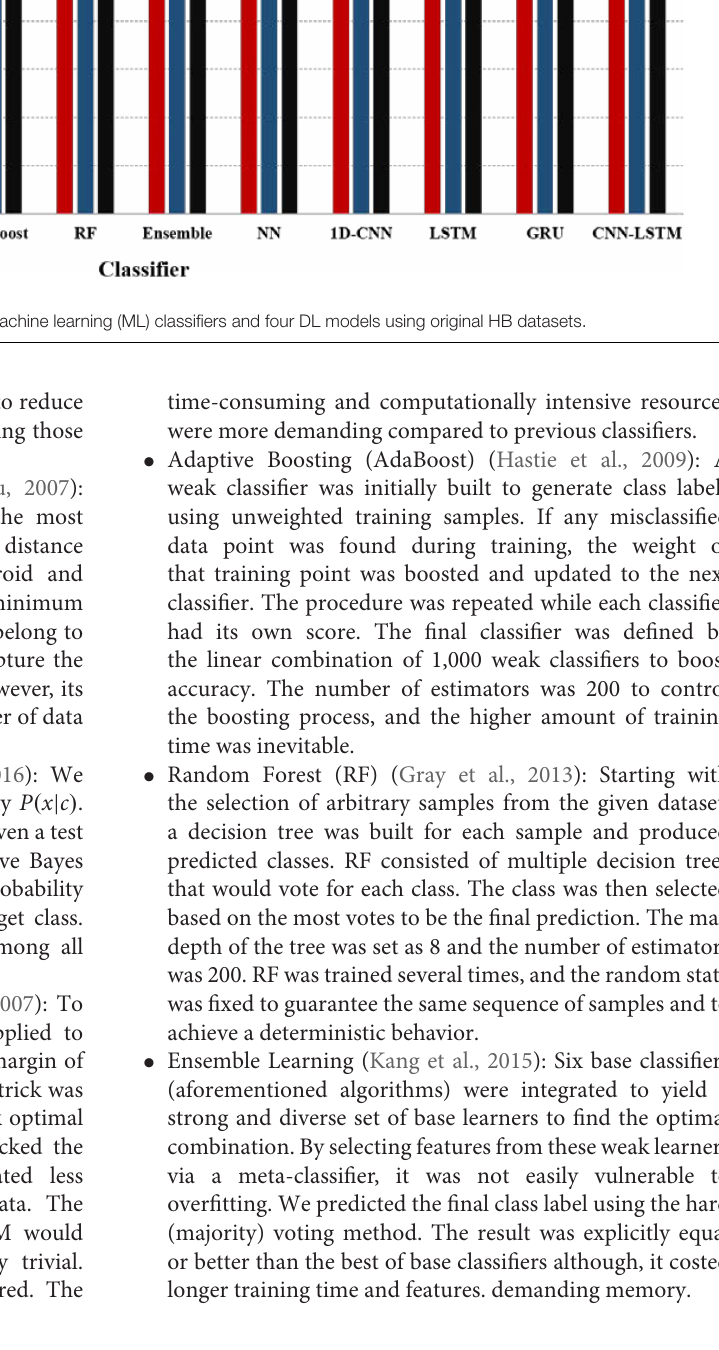
FIGURE 7 | Classification comparisons of accuracy between eight machine learning (ML) classifiers and four DL models using original HB datasets.